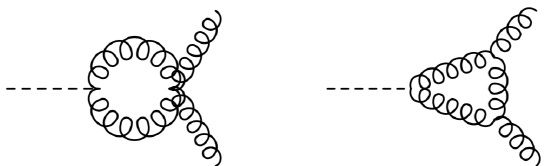
Figure 4 . QCD one loop contribution to φ 4 → G G